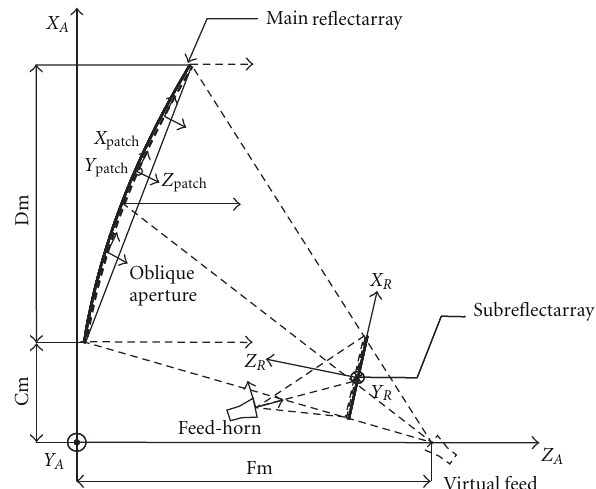
Figure 10: Scheme of a dual-reflectarray structure analysis.